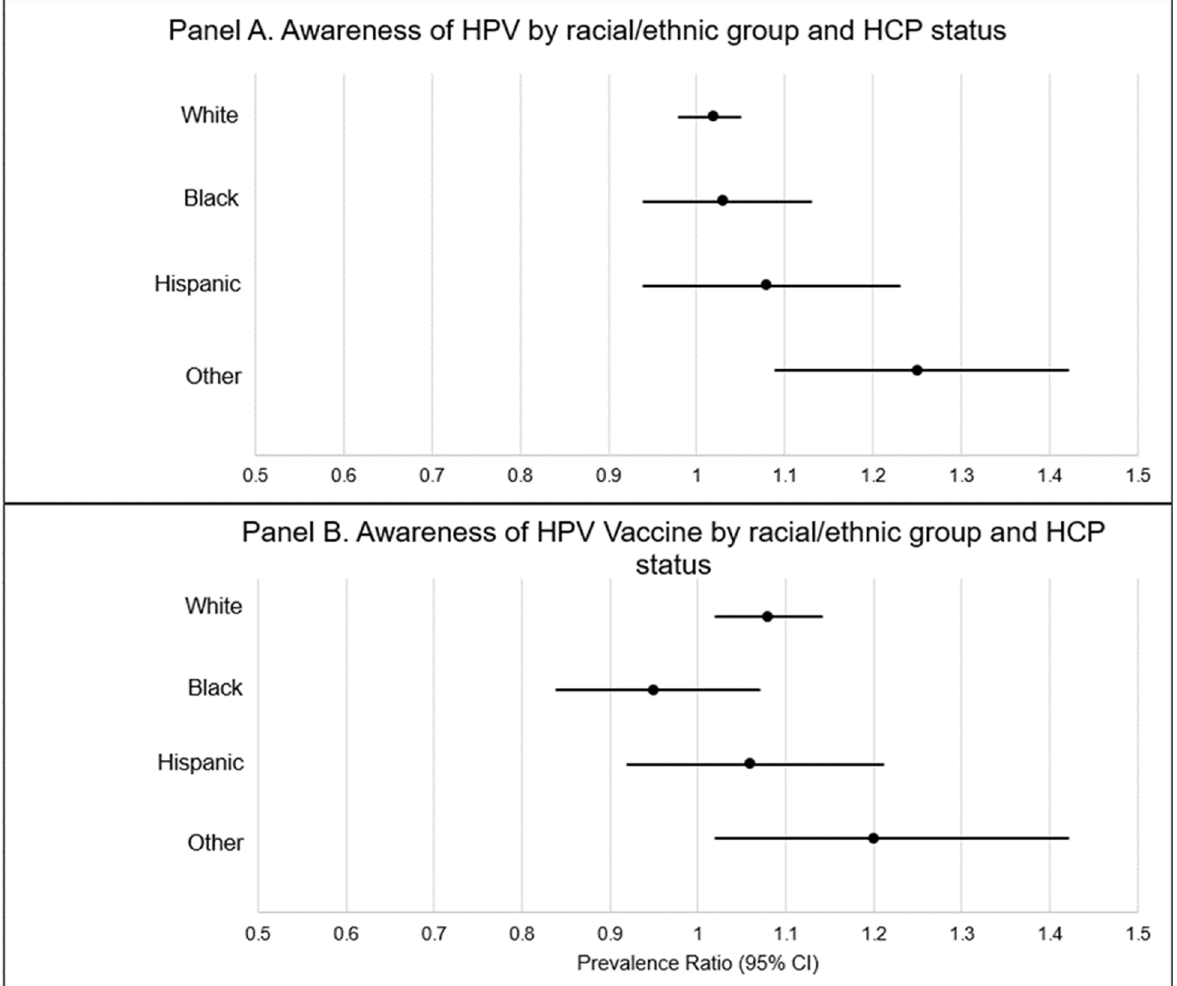
Figure 2. Awareness of HPV and the HPV vaccine within racial/ethnic groups by HCP status. Solid black dot denotes prevalence ratio. Black line denotes 95% confidence interval.